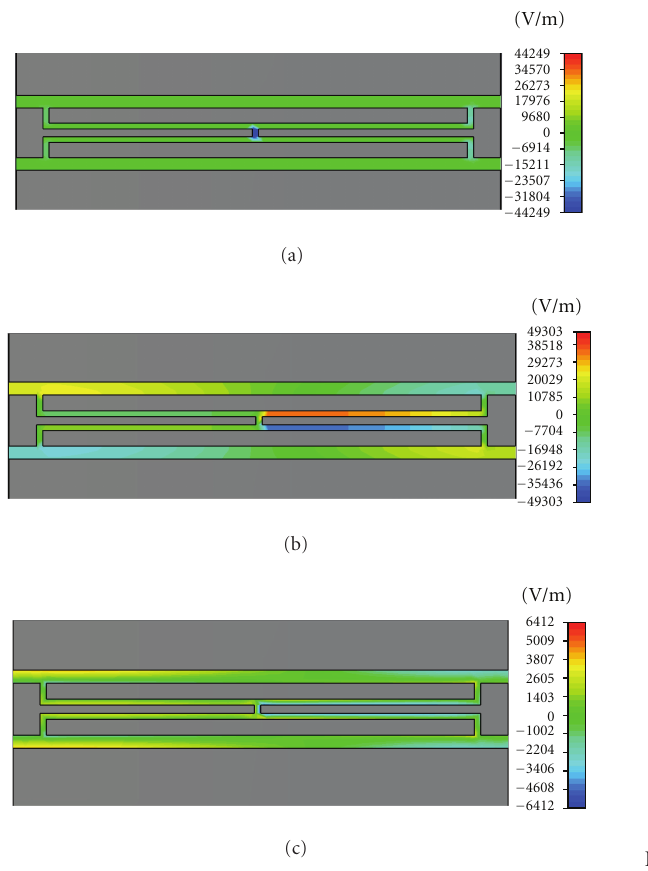
Figure 9: Electric field (V/m) distribution inside the discontinuity structure at 8GHz under quasi-TEM fundamental mode (a) E x , (b) E y , and (c) E z .